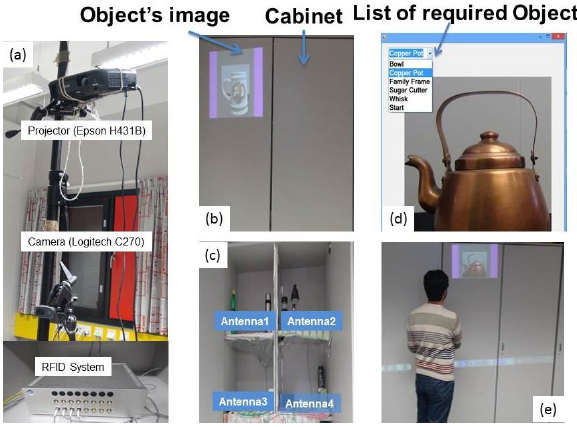
Figure 2 . (a) Our prototype system consists of a camera and a projector on the pole and a RFID system is placed inside the cabinet, (b) the scene of the local site with the projected image, (c) four shelves of the cabinet with RFID antennas,